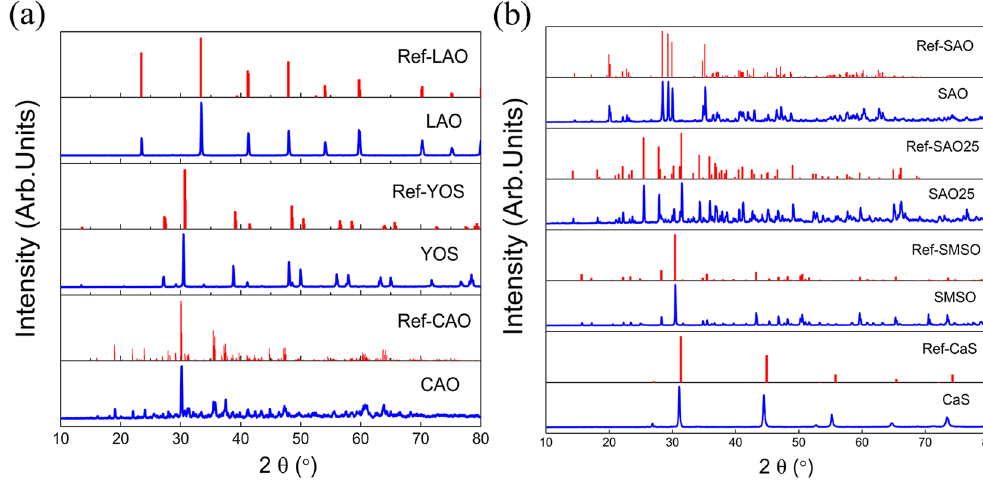
Figure 1. Measured XRD patterns (blue curves) of the phosphors investigated and standard XRD patterns (red curves) of the host crystal